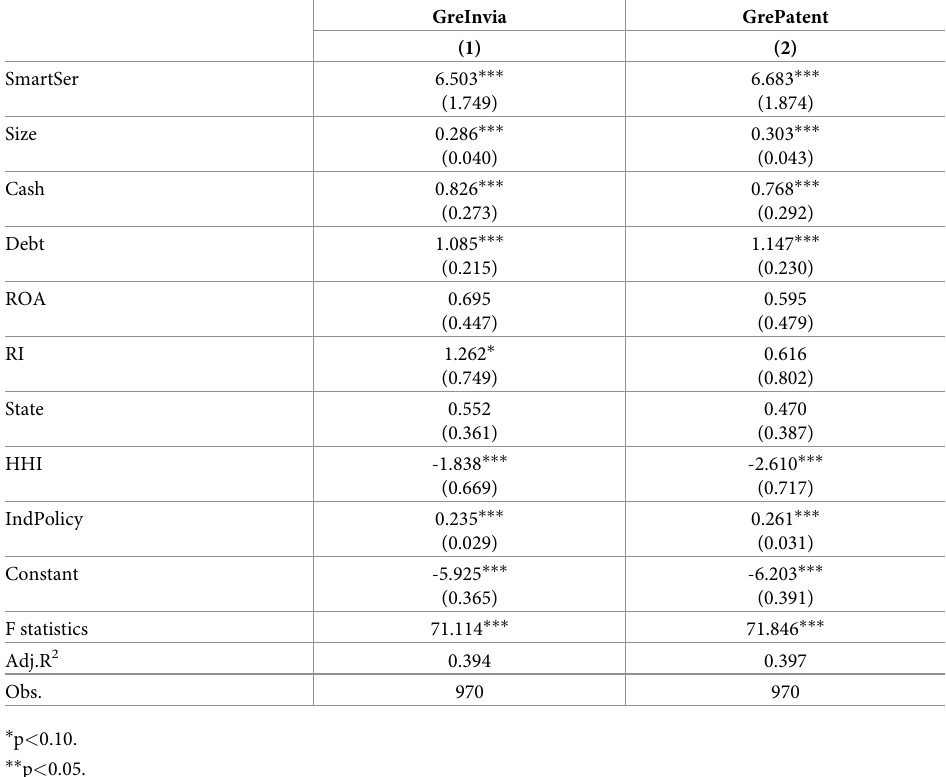
Table 6. Results of baseline